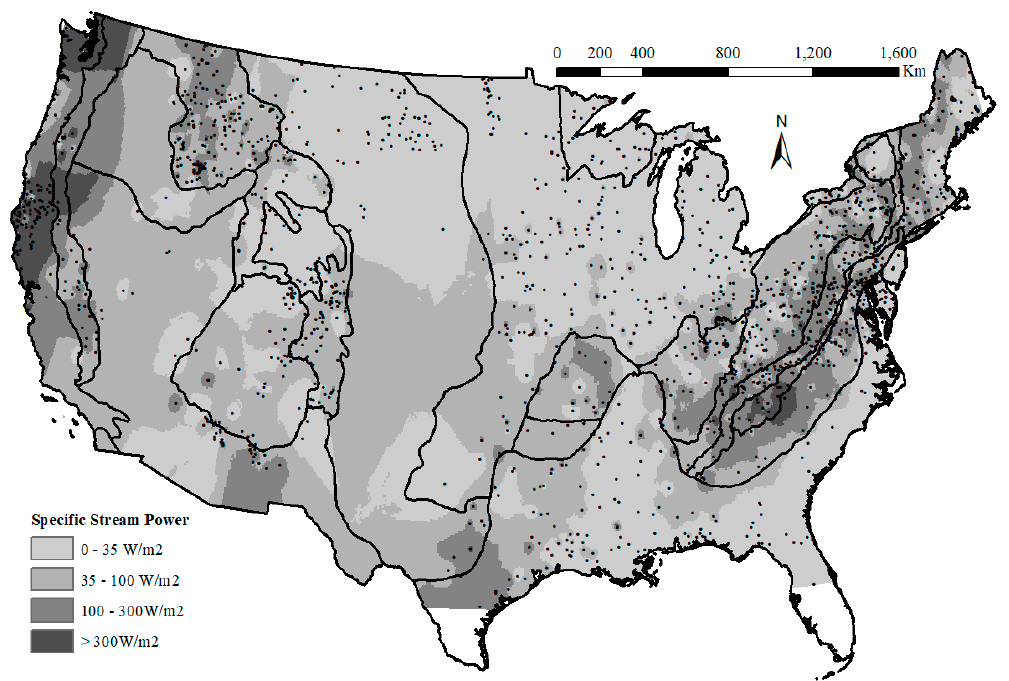
Figure 6. Map of interpolated “available stream power” over the contiguous U.S. The map was prepared using the log values of stream power computed for 1829 points. Black dots on the map indicate the locations of the actual D50 data.